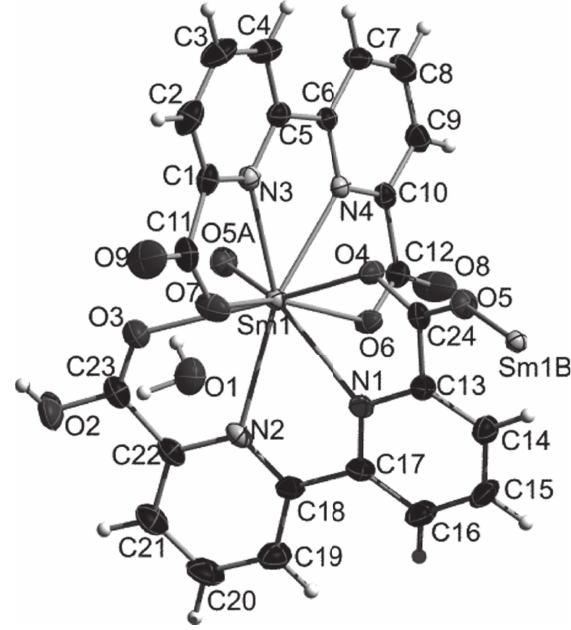
Table 1: Data collection and handling.